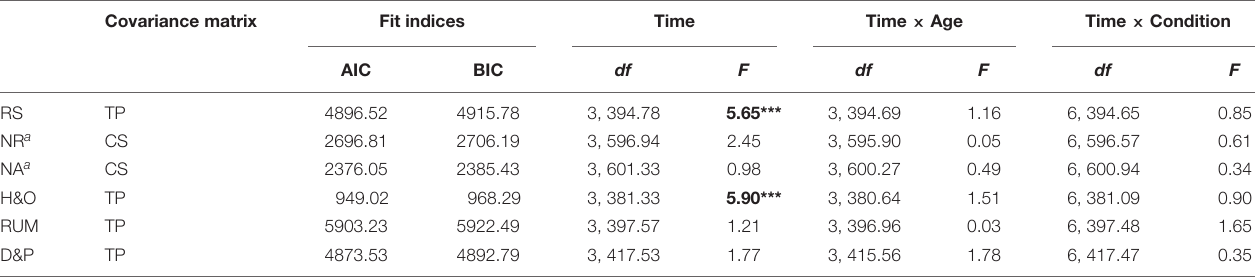
TABLE 4 | The effect of condition on action mechanisms over time using mixed effects models. Covariance matrix Fit indices Time Time × Age